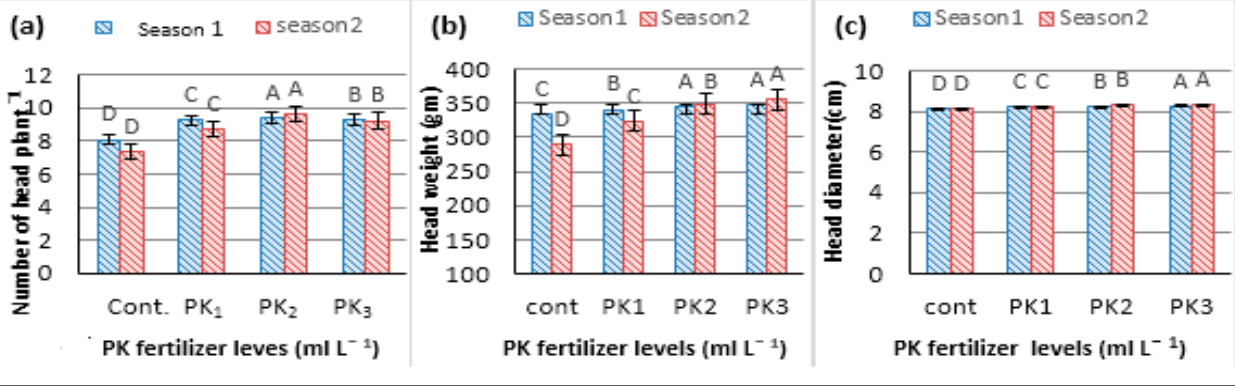
Figure 3. Head characteristics (means ± SE) of globe artichoke as affected by the PK fertilizer levels (Control: without, PK 1 : 25, PK 2 : 50 and PK 3 : 75 mL L − 1 ) on ( a ) Number of head plant − 1 , ( b ) Head weight (g) and ( c ) Head diameter (cm). Letters in the figures indicate that the mean ± SE treatments with the same letters were not significantly different according to Duncan’s multiple range test for p < 0.05.